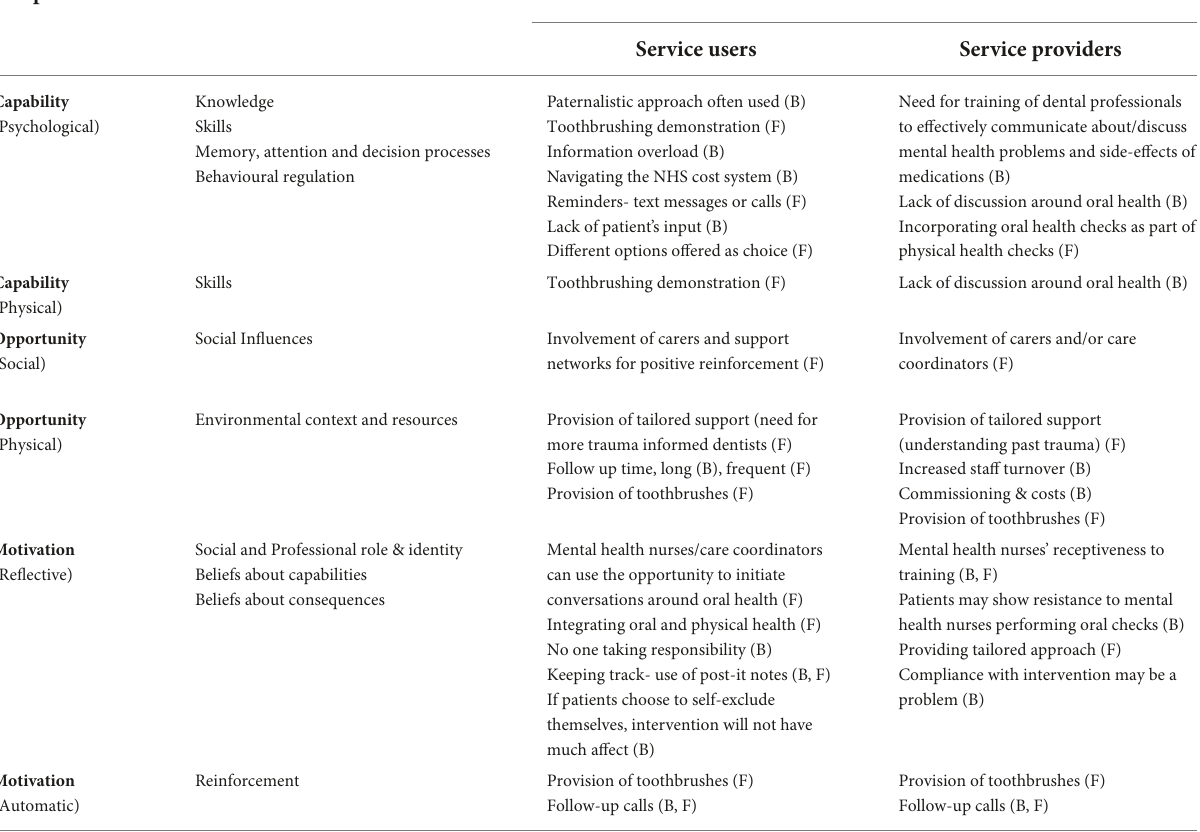
TABLE 4 Barriers and facilitators under the TDF domains and mapped to the COM-B model. COM-B